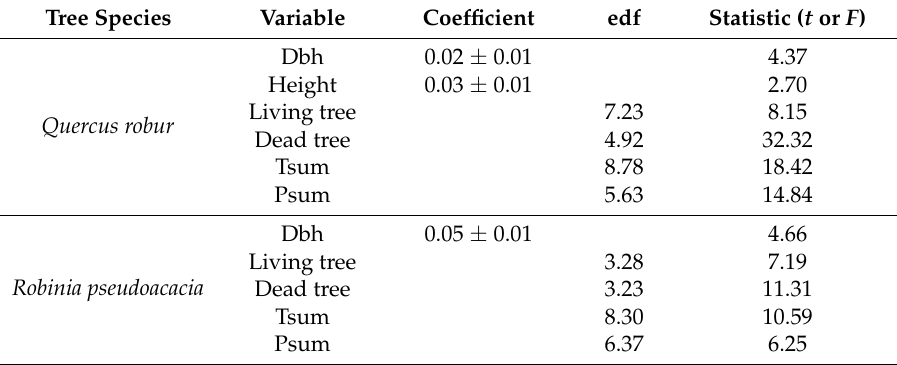
Table 2. Parameters of the Generalized Additive Mixed Models (GAMMs) fitted to basal-area increment data of living and recently dead trees in oak ( Quercus robur ) and black locust ( Robinia pseudoacacia ) as a function of tree size (Dbh, diameter at breast height), tree status (living vs. dead tree), and summer climate (Tsum, mean summer temperature; Psum, total summer precipitation). The effective degrees of freedom (edf) of the smoothing terms are also shown. All statistics ( t or F ) are significant at the 0.05 level. Tree Species Variable Coefficient